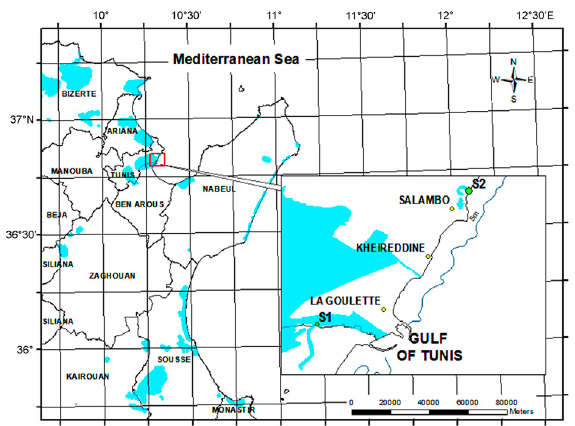
Fig. 1. – Map of the sampling sites in the Gulf of Tunis (Tunisia): S1, port of Rades; S2, Punic port of Carthage. Blue colour signifies the